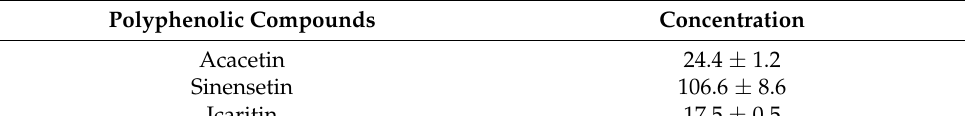
Table 3. Concentration of polyphenolic compounds in CBE (milligrams per kilogram of extract).